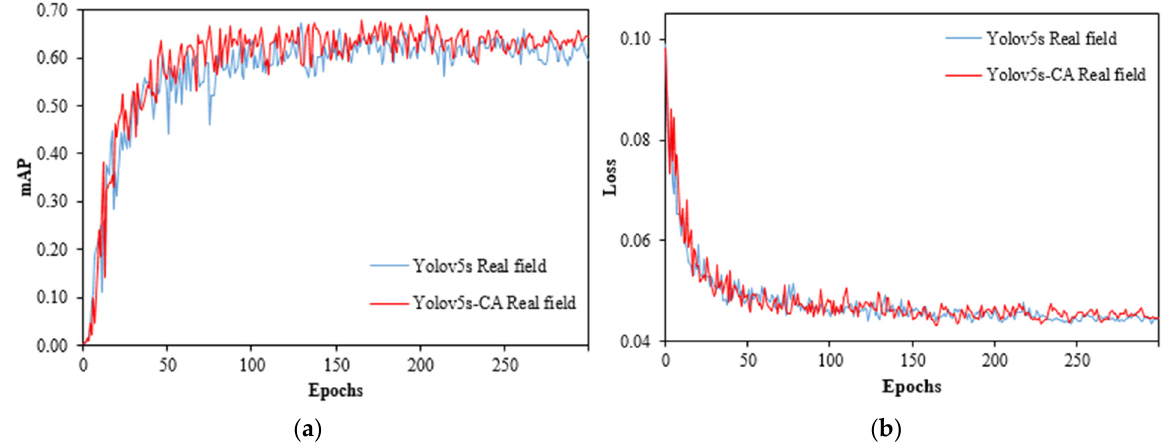
Figure A1. Experimental results of each model on the field-collected dataset. ( a ) mAP @0 . 5 curves for the real field dataset. ( b ) Loss curves for the real field dataset. Table A1. Number of images in each data